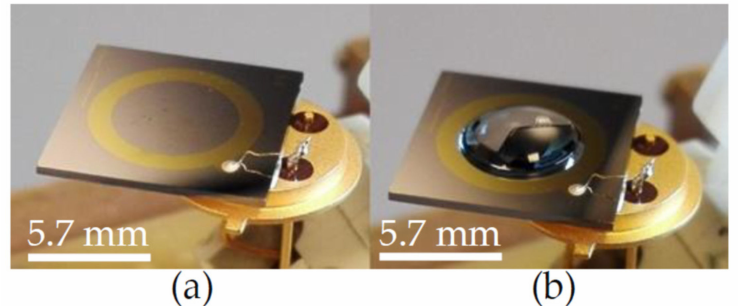
Figure 3. Photograph of an impedance biochip with Au ring electrode wire-bonded to a diode socket ( a ) before and ( b ) after filling 20 µ L DI water inside the top electrode area. The outer and inner diameter of the ring electrode amounts to 5.7 mm and 7.8 mm, respectively. Courtesy of HZDR Innovation GmbH (https://hzdr-innovation.de/en/products/impedance-biochip/).